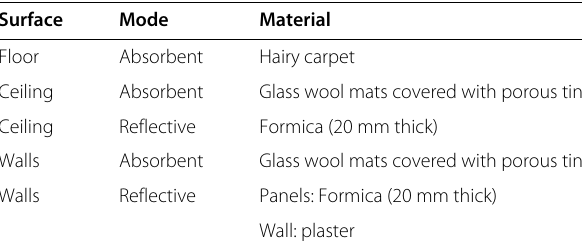
Table 8 Materials covering the acoustic laboratory in